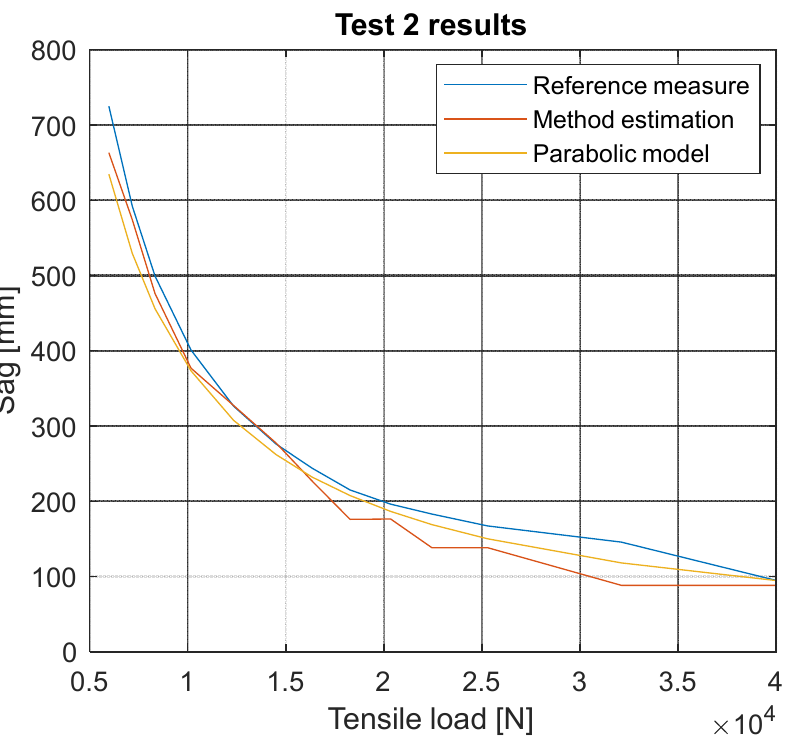
Figure 9. Comparison between the angle value measured by the sensors and the reference one com- puted through catenary equation in correspondence of the sensor position during Test 2. Error bars represent the uncertainty of the sensor measurements. 5. Conclusions In this work, a simple method to estimate the sag value by measuring the conductor slope at the span extremities was derived. The proposed solution can be adopted for both